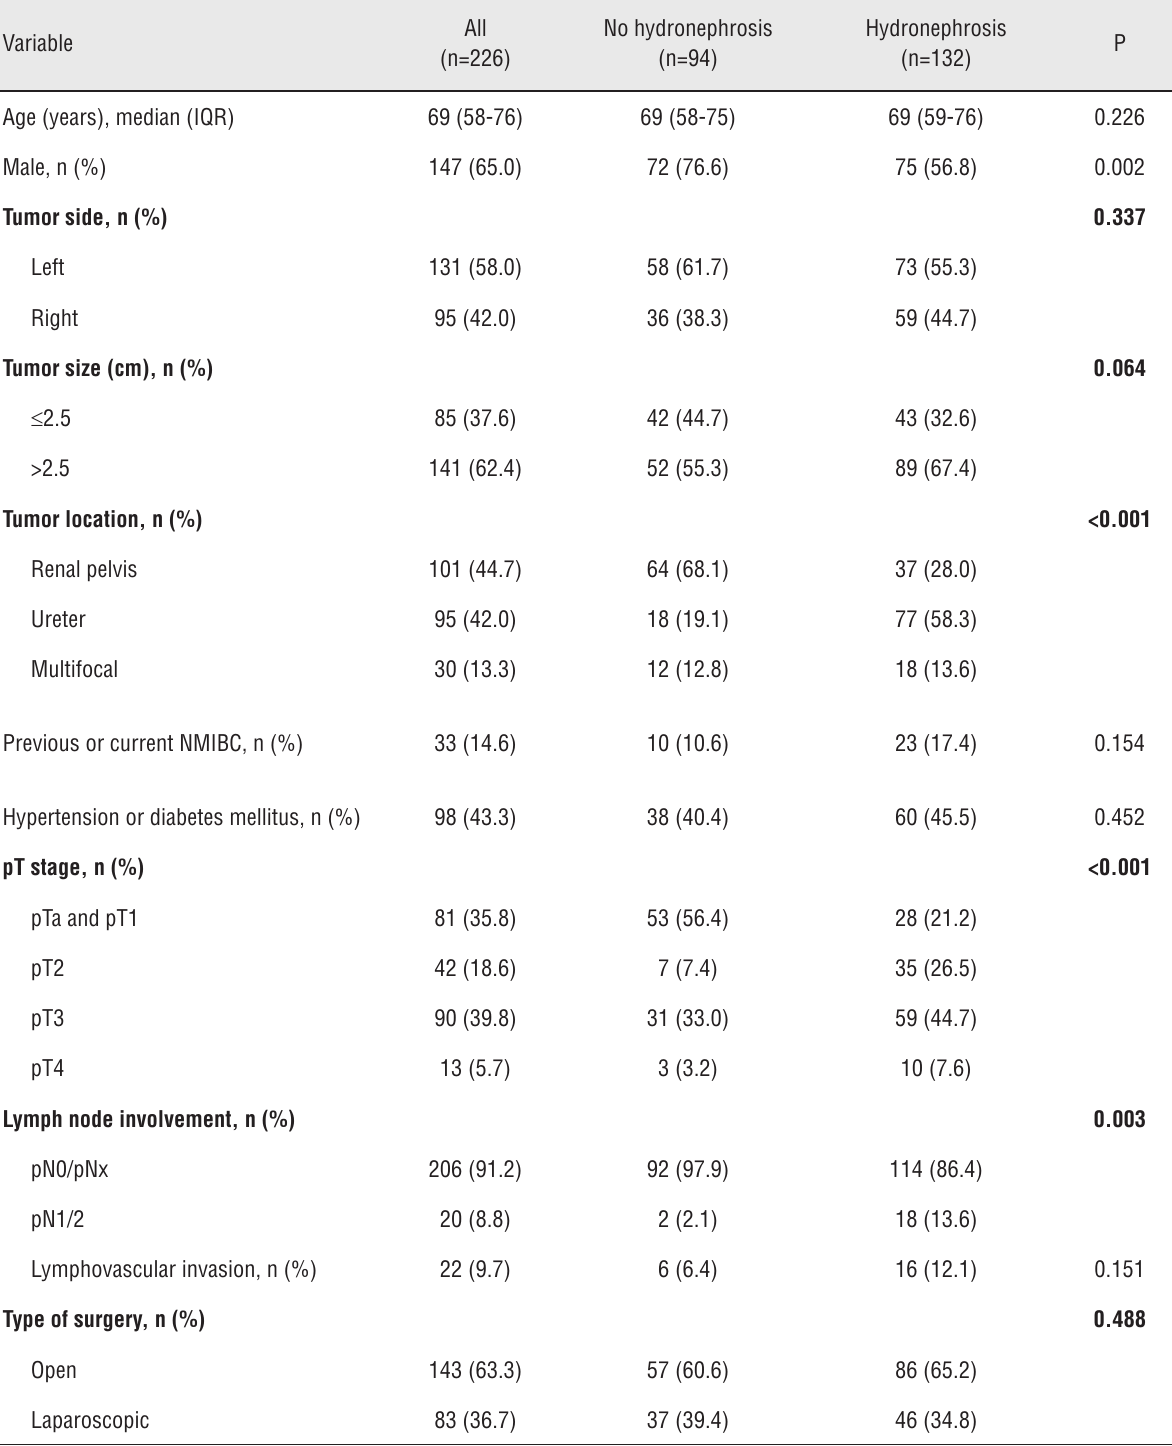
Table 2 - Clinical characteristics of patients with high-grade upper tract urothelial carcinoma.